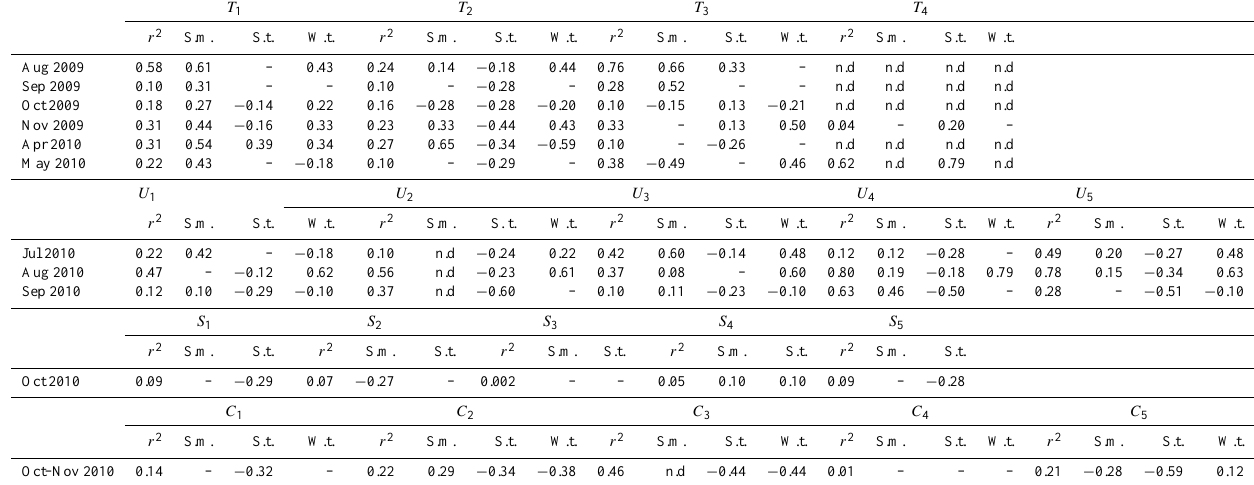
Table 3. Coefficients from multiple linear regression analyses. A value is given only if the variable significantly contributes to explain the variation in the CH 4 exchange. The r 2 shows how well the combined variables explain the variance in the CH 4 exchange. S.m represents soil moisture, S.t denotes soil temperature, W.t shows water table depth and n.d means no data is